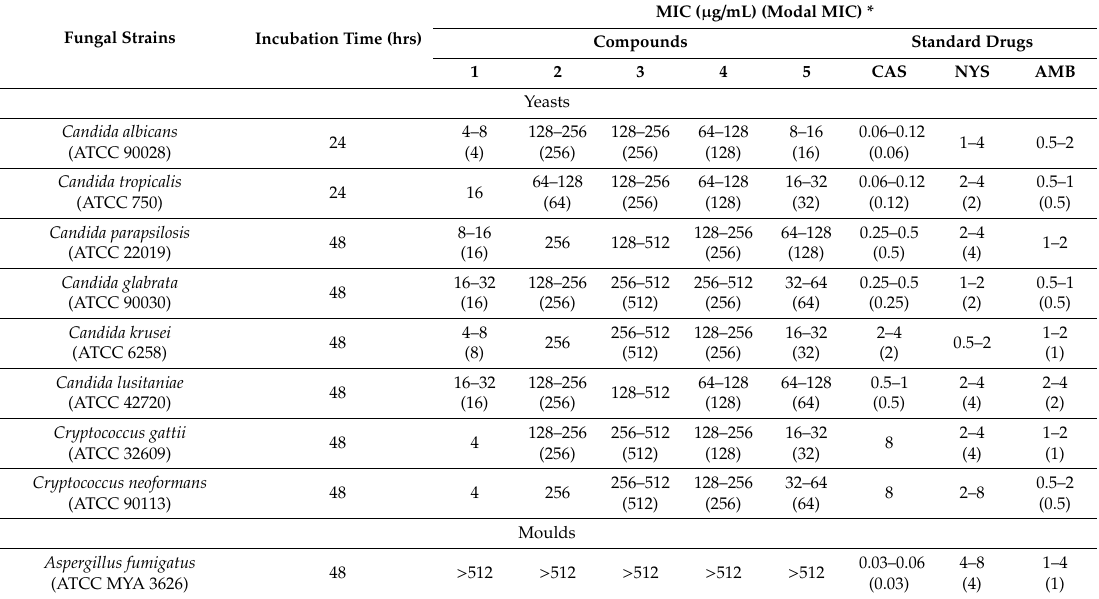
Table 2. Antifungal activity of compounds 1–5 against a range of fungal species as determined by the broth microdilution